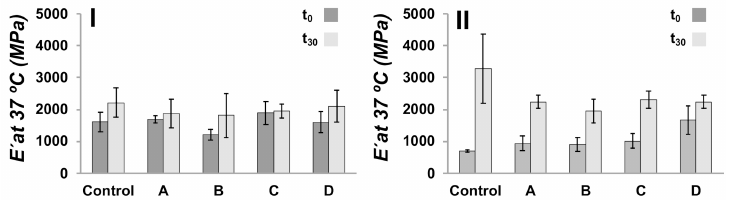
Figure 9. E (cid:48) at 37 ◦ C of ellipsoidal ( I ) and square ( II ) 3D-printed/electrospun composites immersed in SBF media for 30 days. A control sample is a composite prepared without covering the surface of 3D-printed pieces with fibers, and A-D are those composites prepared with a layer of PLA-based fibers: (A) PLA10, (B) PLA/PEG, (C) PLA/PEG/2.5HA, and (D) PLA/PEG/5.0HA.